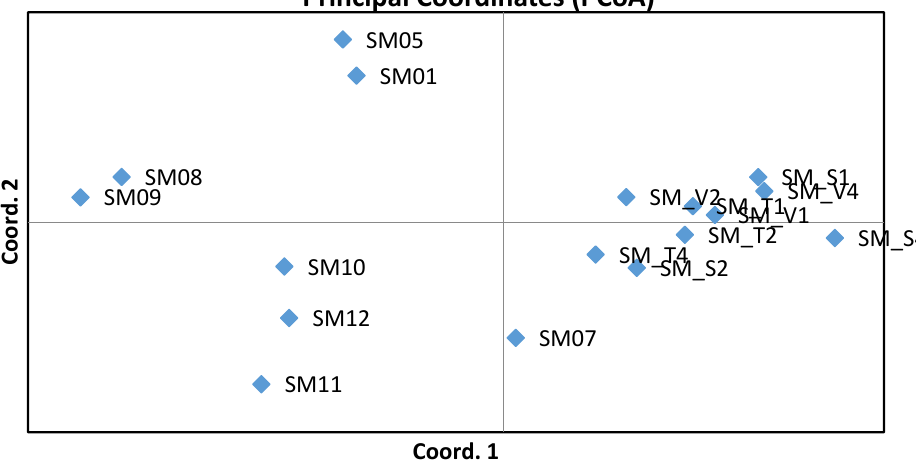
Figure 2. Results of the principal component analysis.